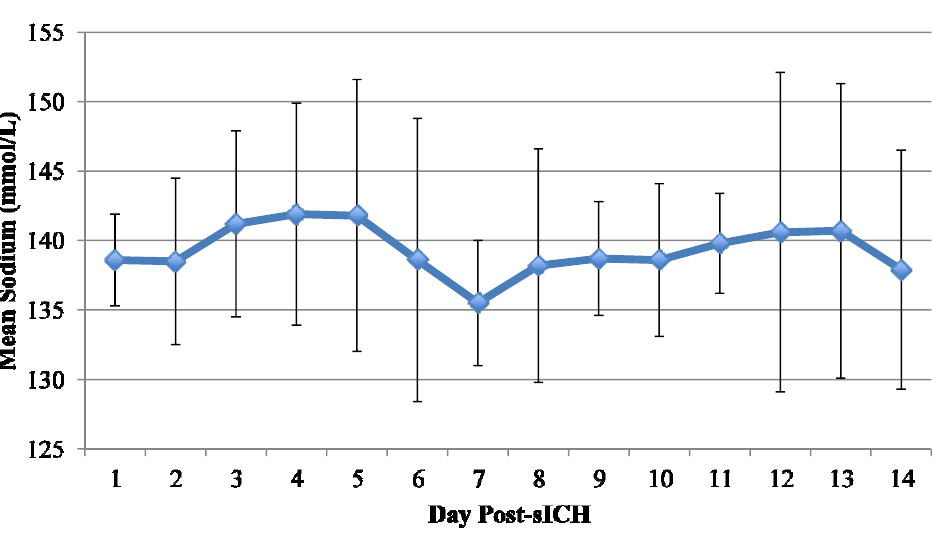
Figure 1. Mean sodium following sICH in patients with hyponatremia.